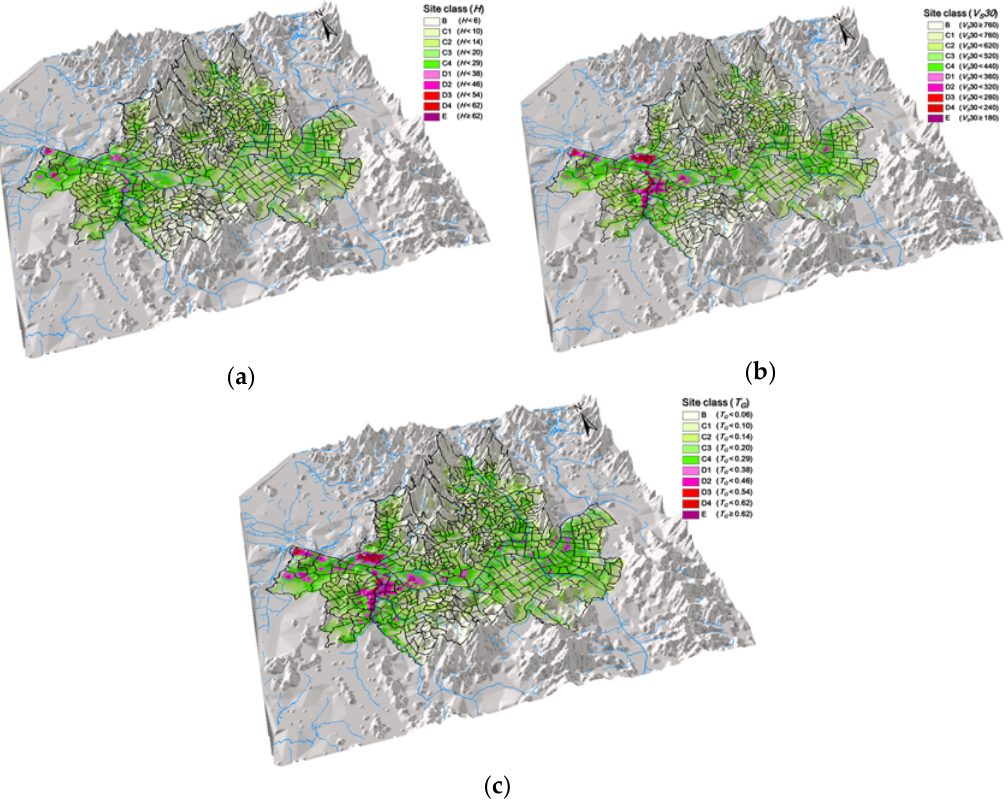
Figure 7. Spatial distribution of site classes for seismic design in Seoul for three site effect parameters: ( a ) bedrock depth ( b ) V S 30 and ( c ) T G . ( a ) bedrock depth ( b ) V S 30 and ( c ) T G